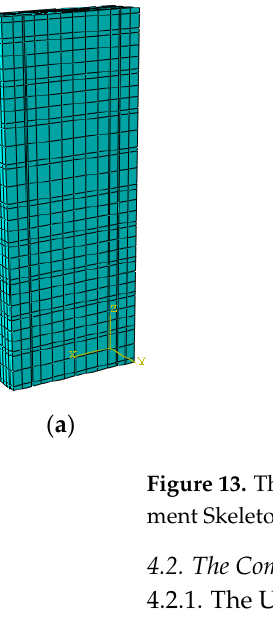
Table 5. The Comparison of the Analytical and Experimental